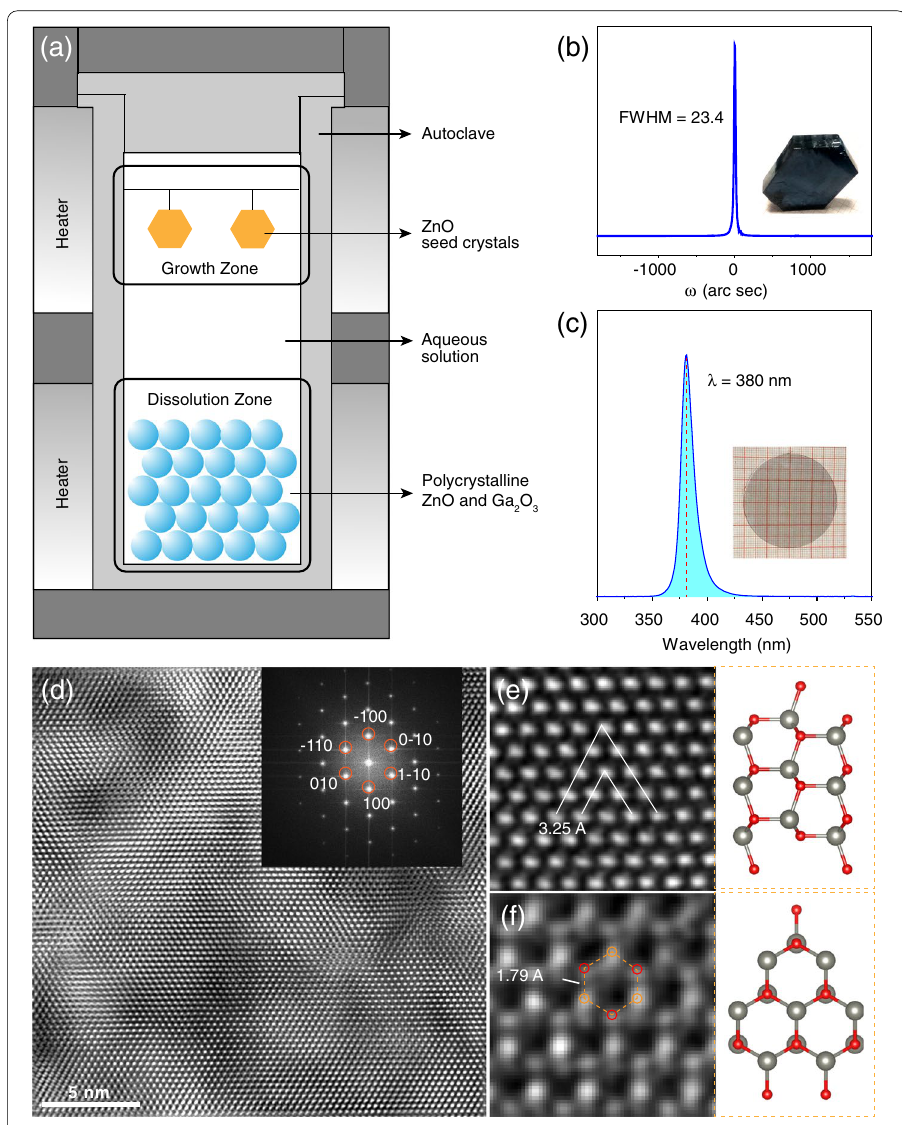
Fig. 1 The growth and characterization of ZnO:Ga single crystal. a Growth diagram of ZnO:Ga single crystal via hydrothermal method. b Single crystal rock curve of ZnO:Ga single crystal. The illustration is the optical photograph of as-grown large-size ZnO:Ga single crystal. c Ultraviolet photoluminescence spectrum of 2-inch ZnO:Ga wafer. Inset is photograph of the ZnO:Ga wafer. d High-resolution transmission electron microscopy (HRTEM) image of the ZnO:Ga single crystal. The selected-area diffraction pattern shows distinct spots with hexagonal shape, indicating a high quality of the ZnO:Ga single crystal. e and ( f ) show the enlarged atoms pattern, corresponding to the b and c plane of crystal respectively. The right diagrams are the crystal structure viewed along b and c plane. The red and gray spheres represent oxygen and zinc atoms,